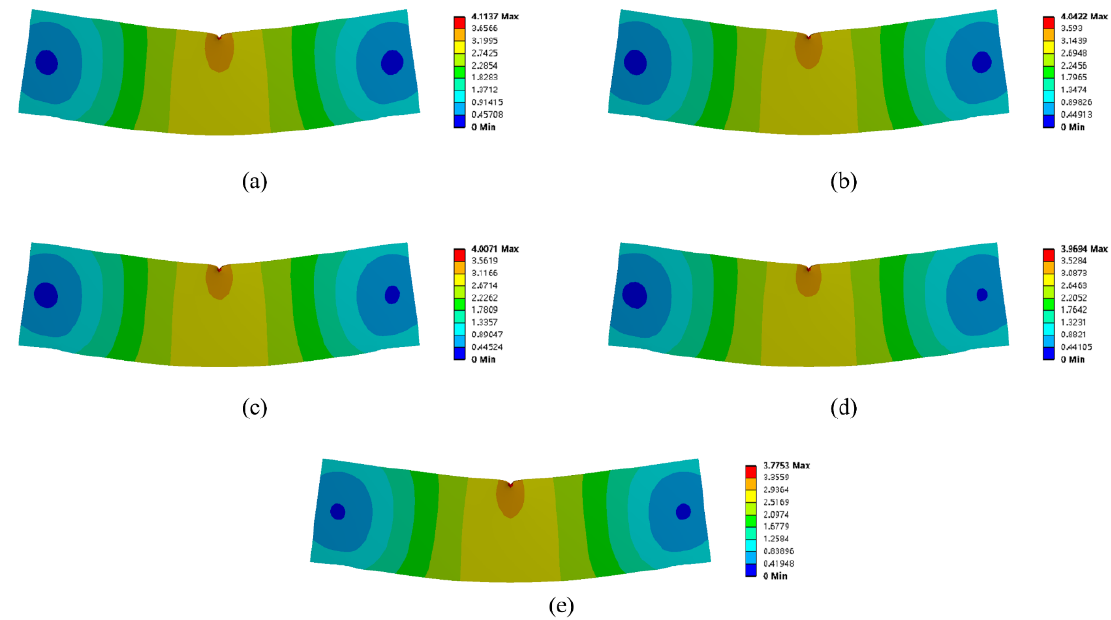
Figure 6. The deformation nephograms of the MBB beam with the assigned effective elastic properties of cross-infill materials. The cross-infill angles are ( a ) 90° – 0°, ( b ) 90° – 14.48°, ( c ) 90° – 30°, ( d ) 90° – 48.59°, and ( e ) 90° – 90°, respectively.